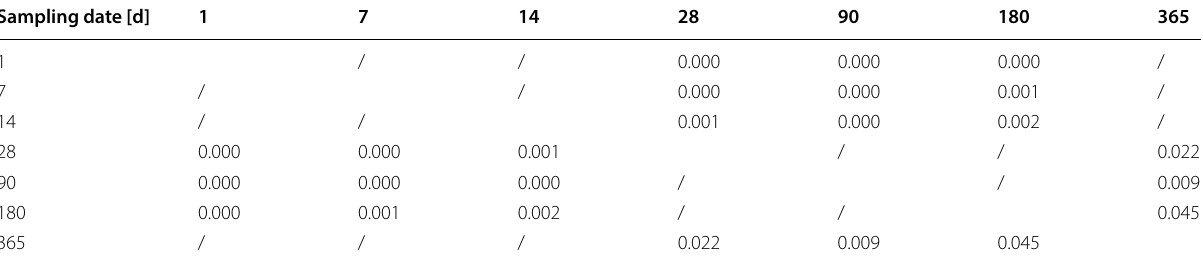
Only significant pairs were stated by their p value. In case of “/” no significant comparison could be observed Table 4 Results of Pearson correlation analysis for comparing the relative variations of the phyla at different AgNP and Ag + concentrations in dependence of exposure time between 90 and 365 days